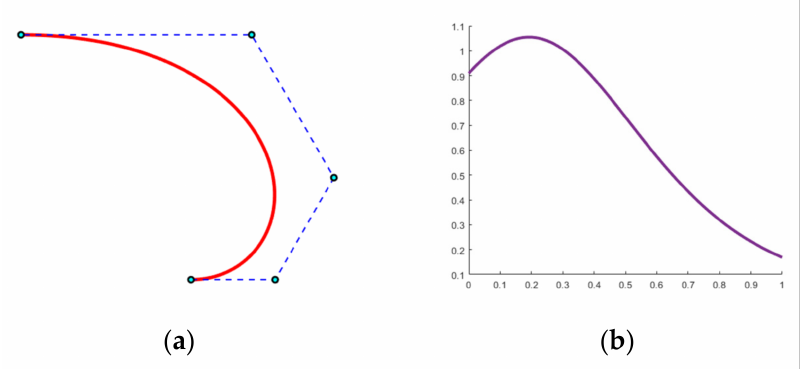
Figure 4. A typical B é zier curve with k = 4 when s · cos θ < 1 ( s ≥ 1). ( a ) s = 1.4, θ = π /3 and ∆ b = [ 1,0 ] T ; ( b ) curvature 0